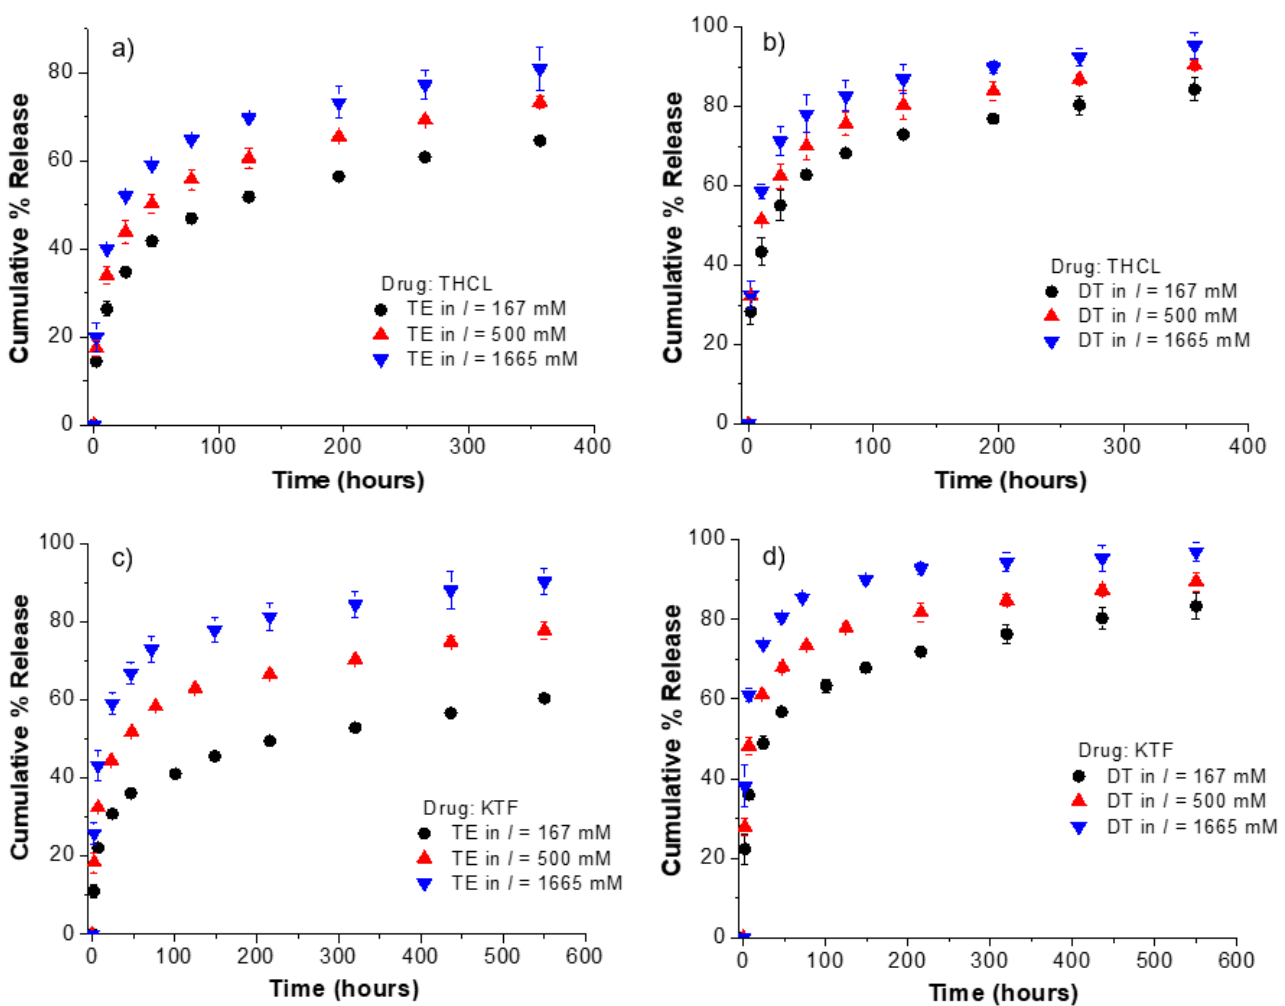
Figure 4. Effect of the ionic strength of the release medium on the cumulative % release kinetics from ACUVUE TruEye ® and Dailies Total1 ® loaded with oleic acid. Oleic acid was loaded at a fixed soaking concentration of 50 mM for all cases. ( a ) THCL cumulative % release from ACUVUE TruEye ® . The total amount of drug uptake: 539.4 ± 11.8 µg. ( b ) THCL cumulative % release from Dailies Total1 ® . The total amount of drug uptake: 362.4 ± 30.3 µg. ( c ) KTF cumulative % release from ACUVUE TruEye ® . The total amount of drug uptake: 781.0 ± 33.6 µg. ( d ) KTF cumulative % release from Dailies Total1 ® . The total amount of drug uptake: 528.9 ± 31.0 µg. Data are presented as mean +/- standard deviation with n = 3.